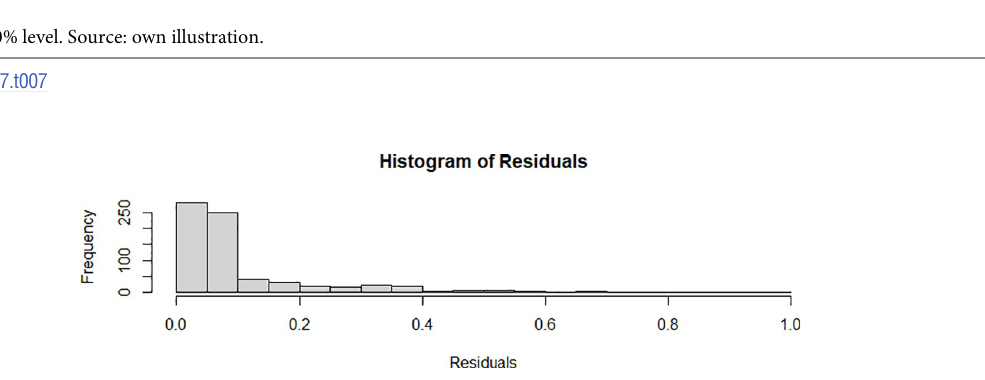
PLOS ONE | https://doi.org/10.1371/journal.pone.0247437 March 12,